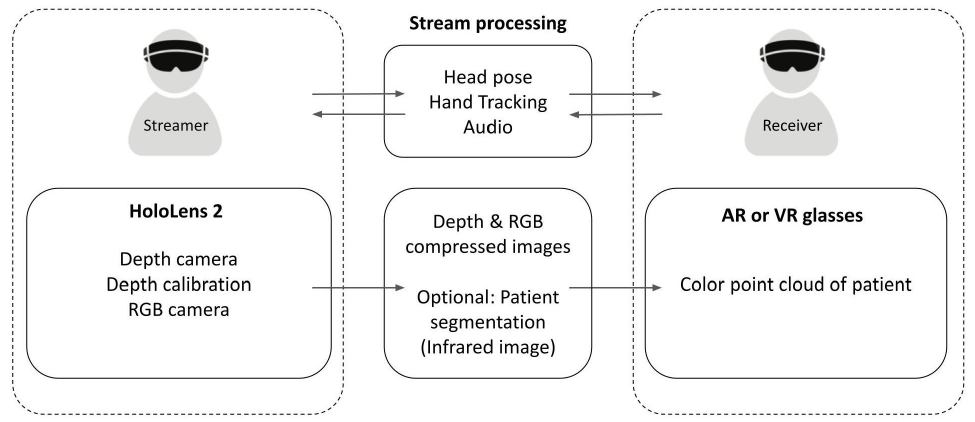
Figure 1. Project architecture and breakdown of the streamer and receiver into their components. By seeing the 3D patient with which the streamer is interacting, the receiver can shadow the interaction or provide